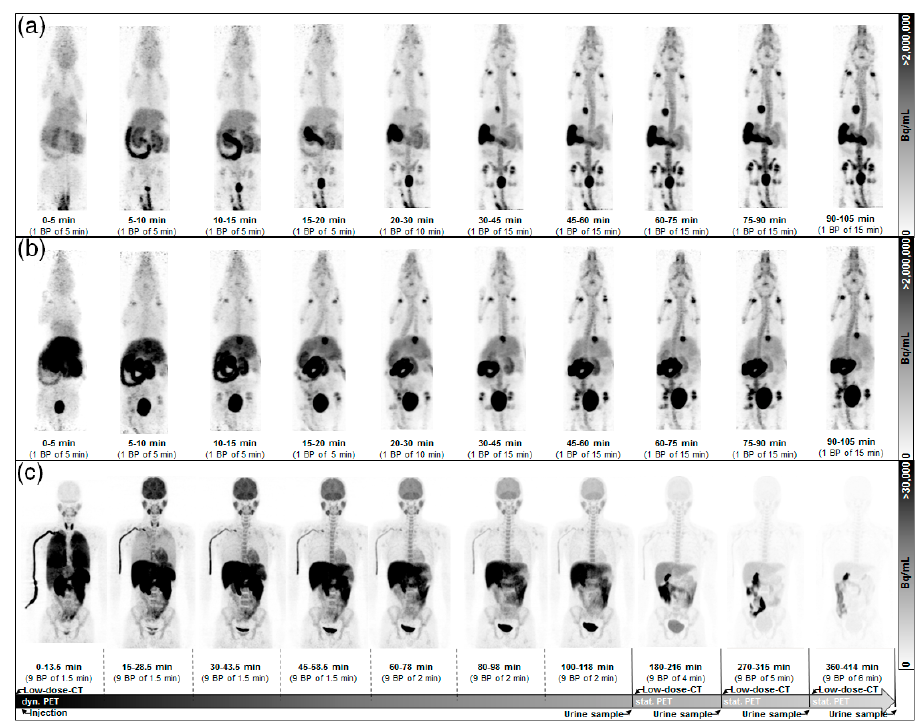
Figure 1. Representative time series (MIP) of mice ( a ), ( b ), and a volunteer ( c ) after i.v. injection of ( S )-( − )-[ 18 F]fluspidine ( a ), ( c ) and ( R )-(+)-[ 18 F]fluspidine ( b ). Furthermore, the diagram shows the scan protocol for humans clarifying the dynamic and static PET part as well as the urine voiding intervals.